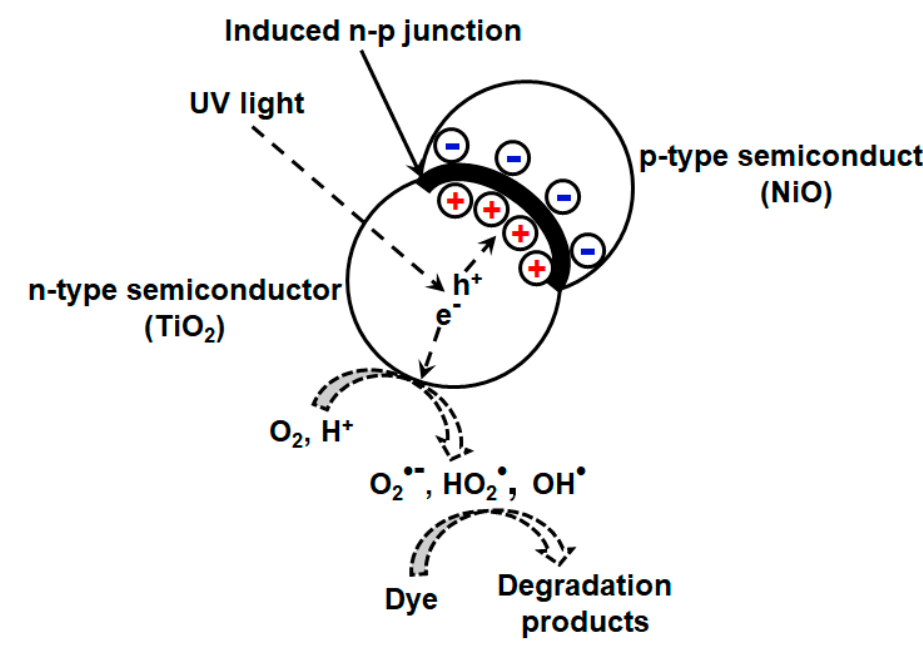
Figure 5. Schematic showing p-n junction at the interface of p-type NiO and n-type TiO 2 semicon- ductors for improved photocatalytic degradation of MO.